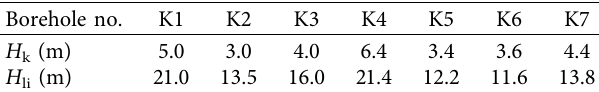
k and H li of the boreholes.